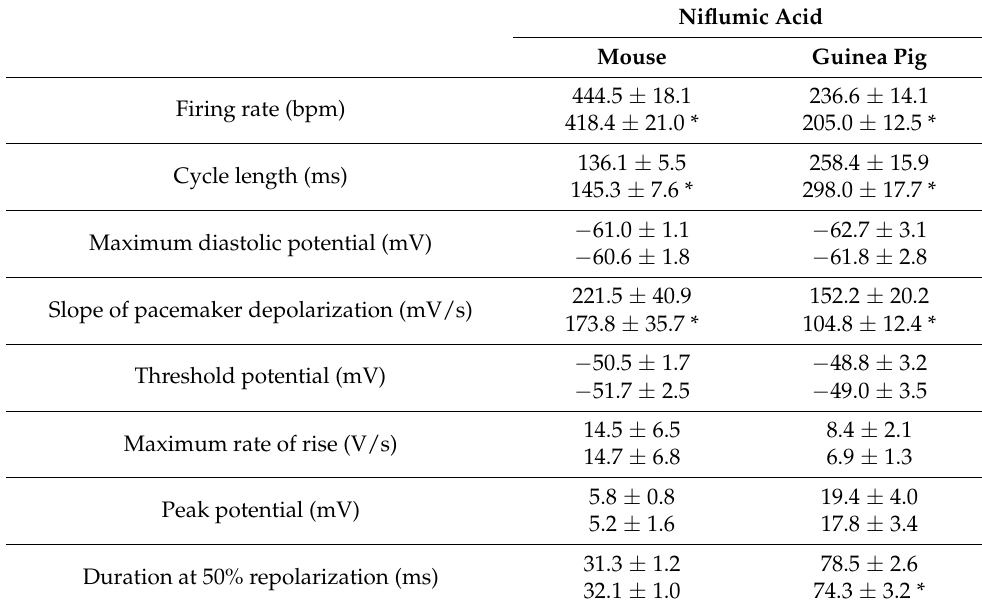
Figure 4. Effect of niflumic acid on the sinus node action potential of the mouse and guinea pig. Typical traces before (black lines) and after (red lines) application of 30 μM niflumic acid. Table 4. Action potential parameters before and after application of niflumic acid.